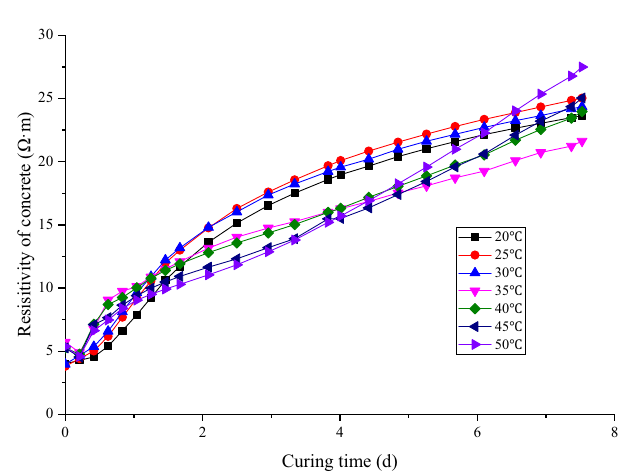
Figure 6. Evolution of concrete electrical resistivity under different curing